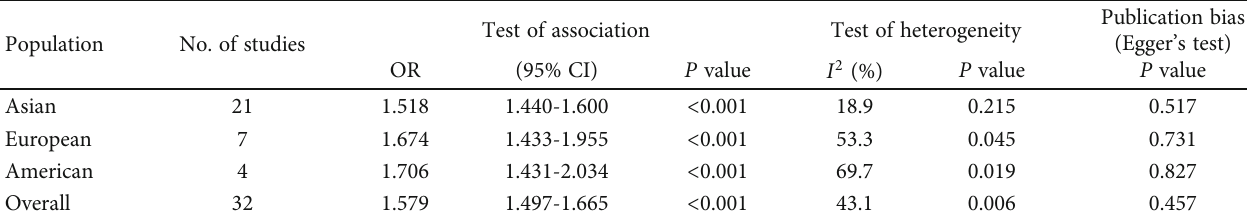
Table 3: Comparison of the association between the STAT4 rs7574865 polymorphism and SLE in each ethnicity.